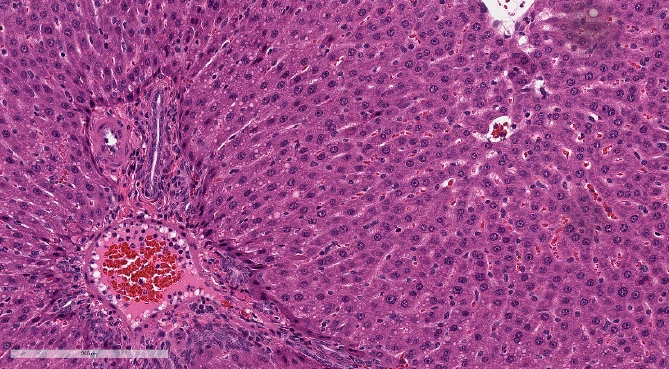
Figure 7. Histopathologic features of the liver at the end of the dosing phase. Liver sections of BNT162b2 (V9) treated animals euthanized 2 days after the third dose (Day 17) showed hepatocytes containing small clear round membrane-bound structures within the cytoplasm (inset). Data are scanned from Study 2.